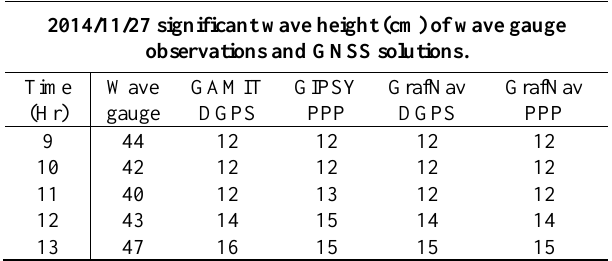
Table 2. Significant wave height of Anping wave gauge observations and GNSS solutions on November 27, 2014.